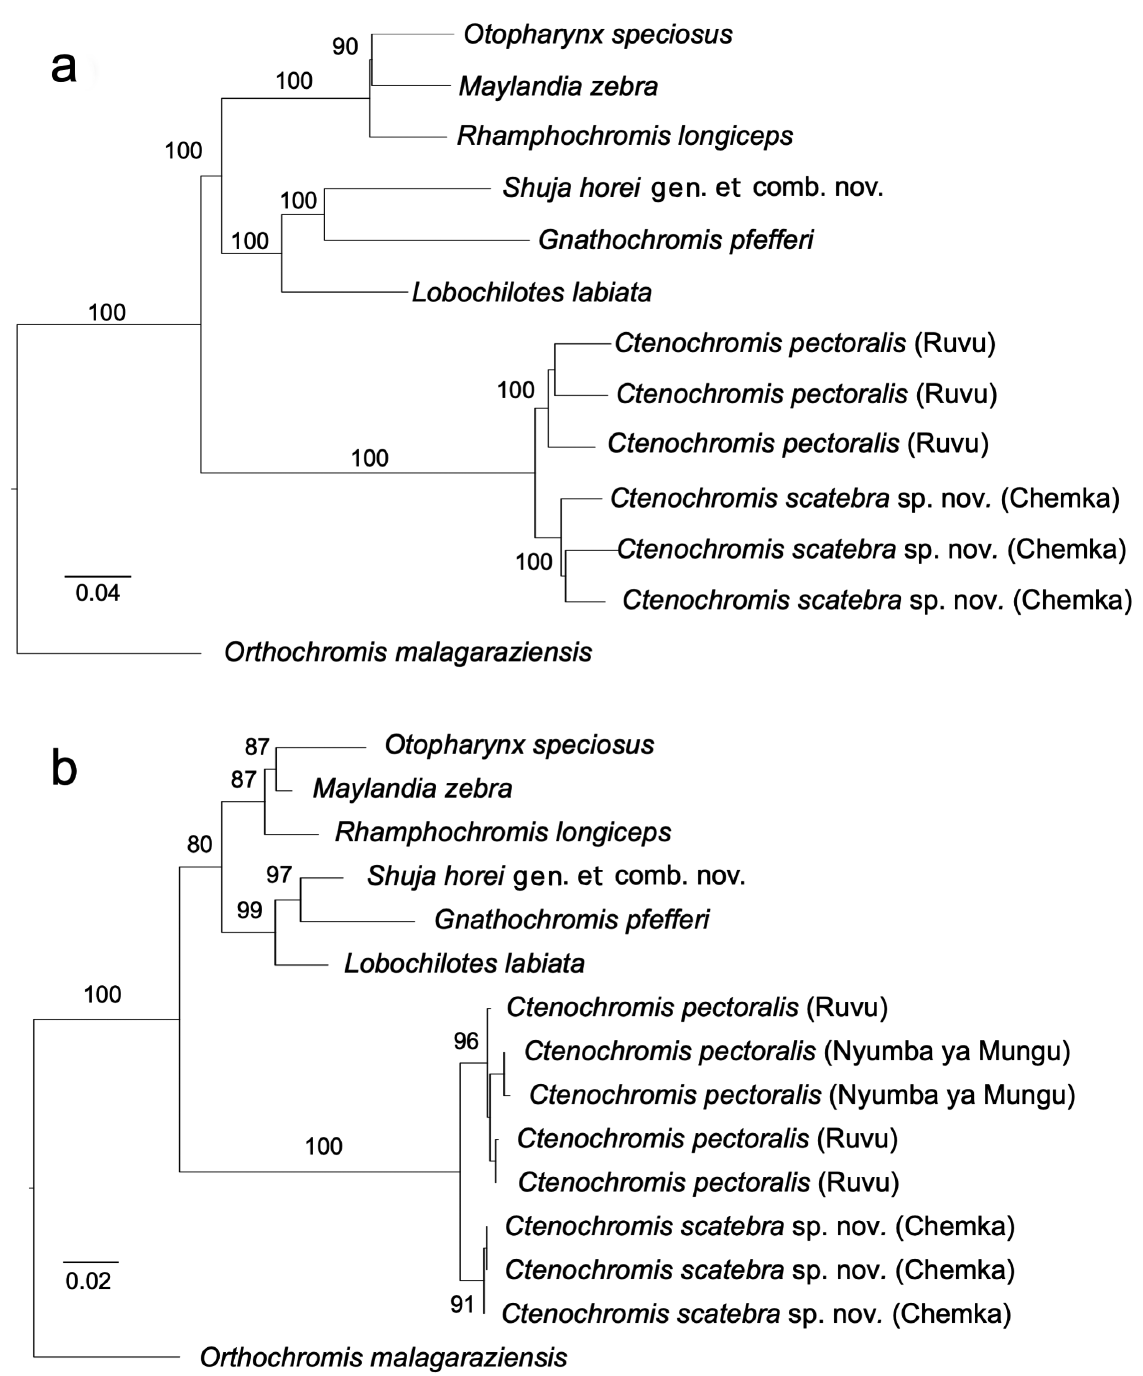
Fig. 4. Phylogenetic reconstructions of representatives of populations of Ctenochromis Pfeffer, 1893, as well as representatives of the Lake Malawi haplochromine radiation, and the Lake Tanganyika Tropheini Poll, 1986. a . Maximum Likelihood phylogenetic reconstruction based on 11 288 SNPs. b . Maximum Likelihood phylogenetic reconstruction based on 1047 basepairs of the entired NADH2 mtDNA gene. In both trees, numbers on branches indicate percentage bootstrap support, and branches with > 70% support are shown. The scale bars represent a measure of genetic distance. See Table 1 for sampling details. Collection localities are in parentheses. Samples from Nyumba ya Mungu have accessions EU753938 and EU753939 and are from Koblmüller et al.